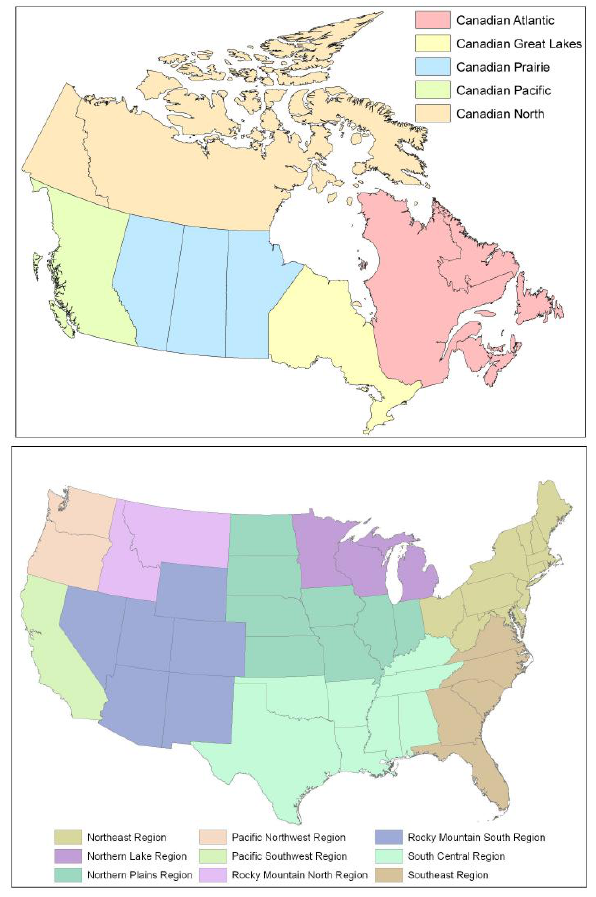
Figure 3. Forest regions in Canada and the United States (Alaska is not shown here). Fig. 3. Forest regions in Canada and the United States (Alaska is not shown